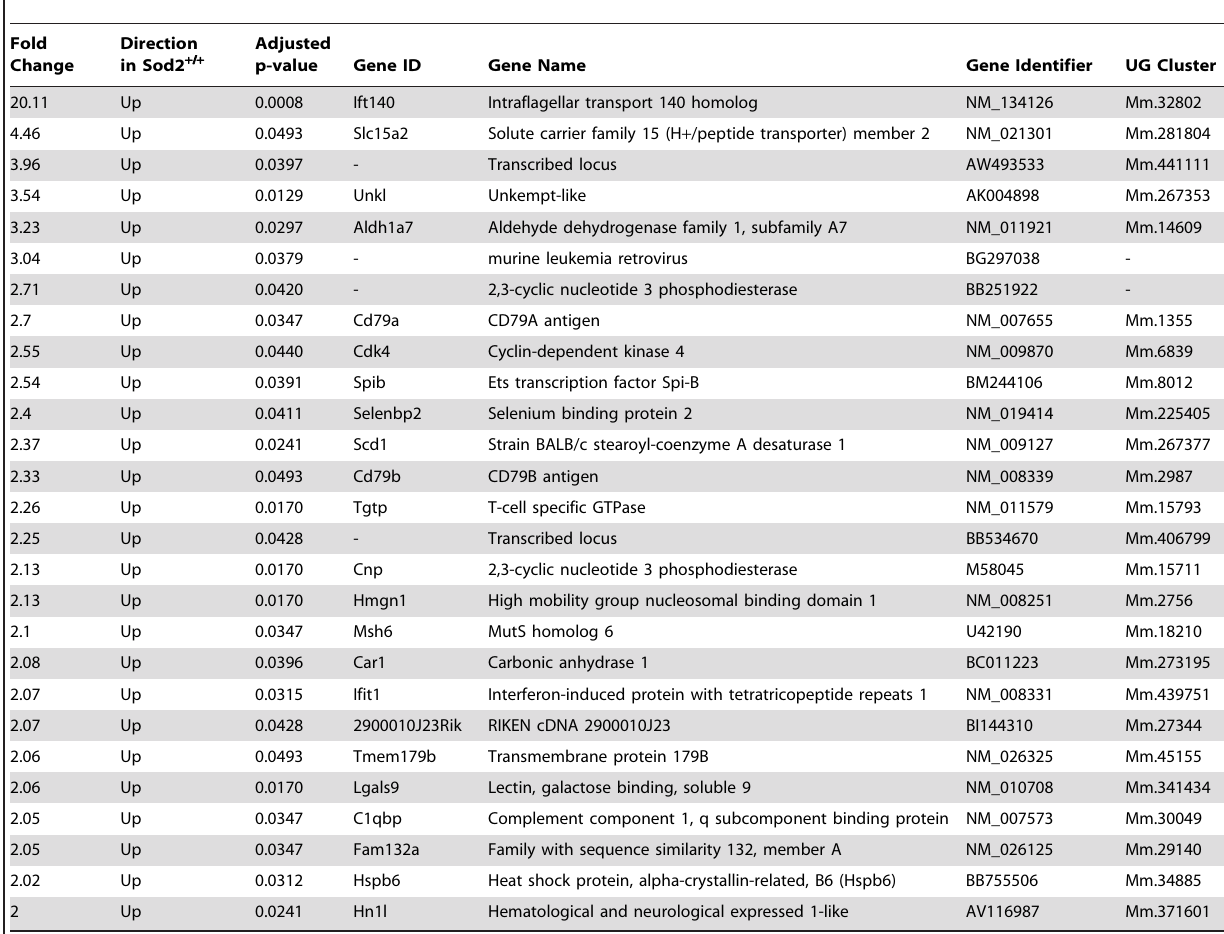
Table 2. List of Expressed Erythroblast Transcripts/Genes with Increased Expression in Sod2 + / + Compared to Sod2-/- Cells.